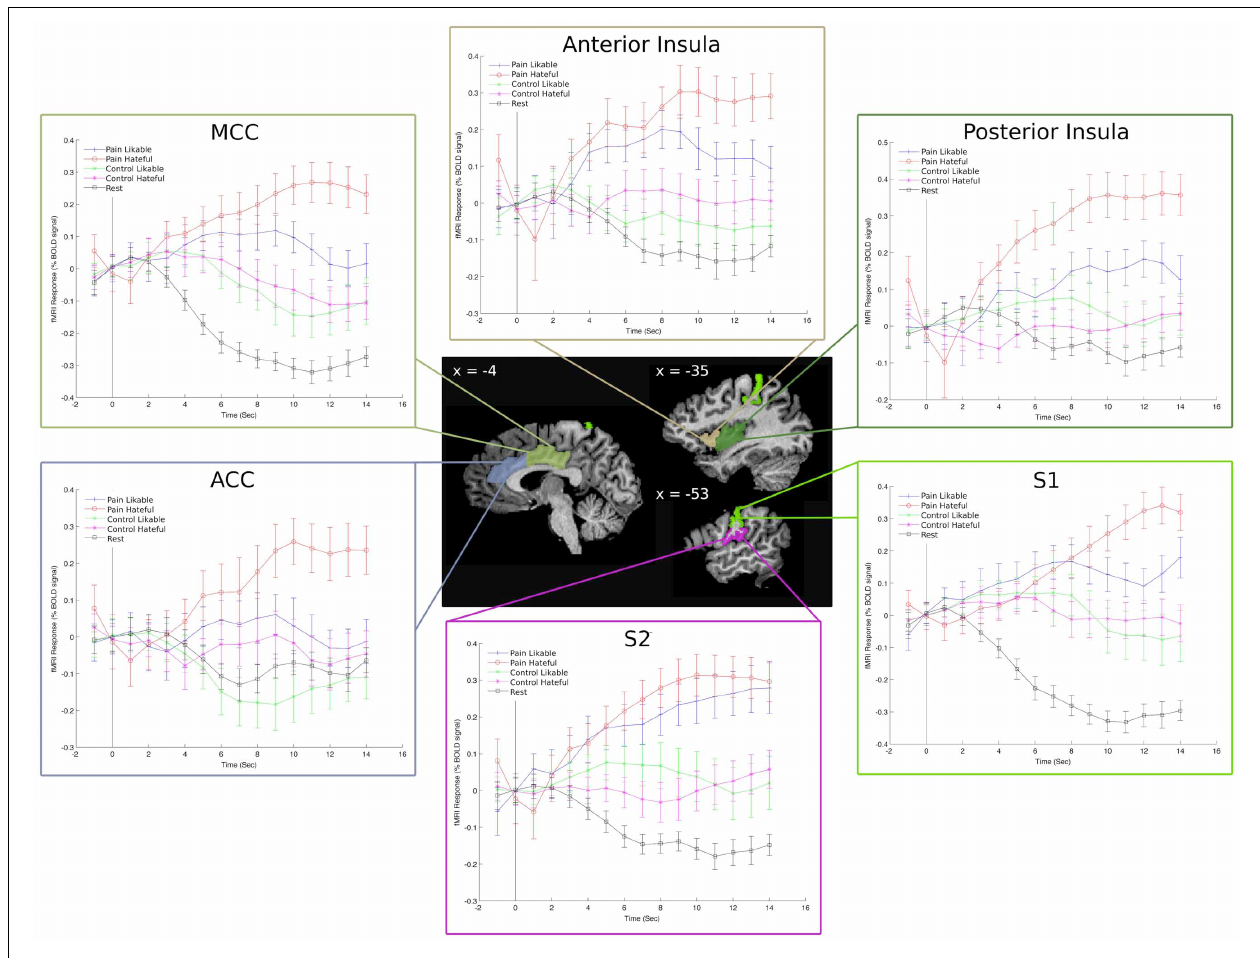
FIGURE 3 | Event Related Averages for the percent signal change in each condition in left-hemisphere hand-drawn ROIs. The “rest” line refers to the time course of activity during the rest condition and is there as a comparison to the video-based stimuli. These plots reveal a